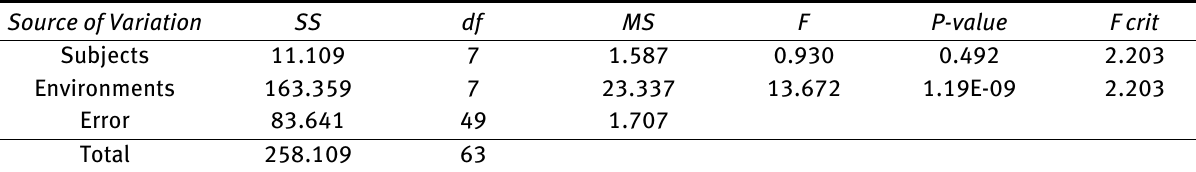
Table 1: Analysis of variance of outdoor ratings in UK Source of Variation SS df MS F